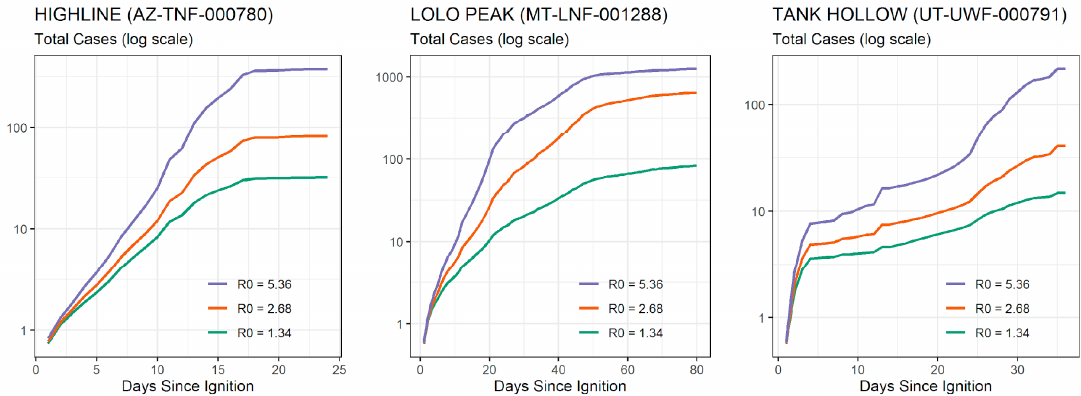
Figure 5. The total number of infected individuals over the duration of each incident under the low (R0 = 1.34), medium (R0 = 2.68), and high (R0 = 5.36) infection rates. Note that the vertical axis is log scaled. All simulations assume the infection rate of 1% of the arriving personnel.